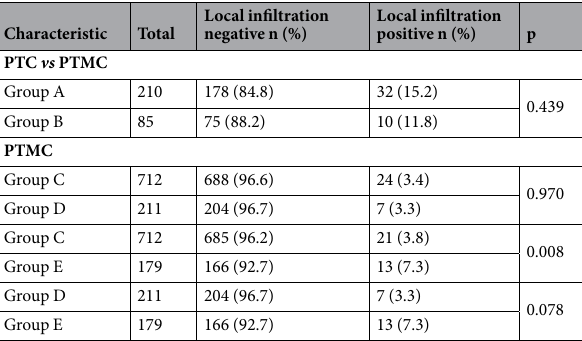
Table 4. Differences in lymph node metastasis between the different local infiltration groups. Group A: PTC, unifocal with diameter > 1 cm and ≤ 2 cm; Group B: PTMC multifocal with total tumor diameter (TTD) > 1 cm and ≤ 2 cm; Group C: PTMC unifocal with diameter ≤ 1 cm; Group D: PTMC multifocal with TTD ≤ 1 cm; Group E: PTMC multifocal with TTD > 1 cm.